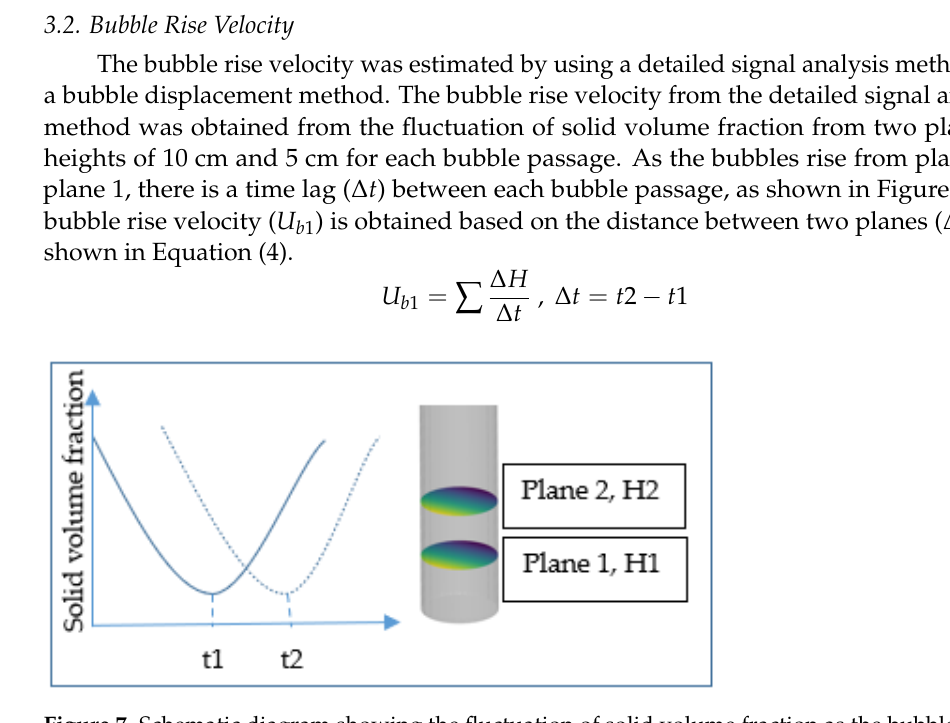
Figure 7. Schematic diagram showing the fluctuation of solid volume fraction as the bubble passes the